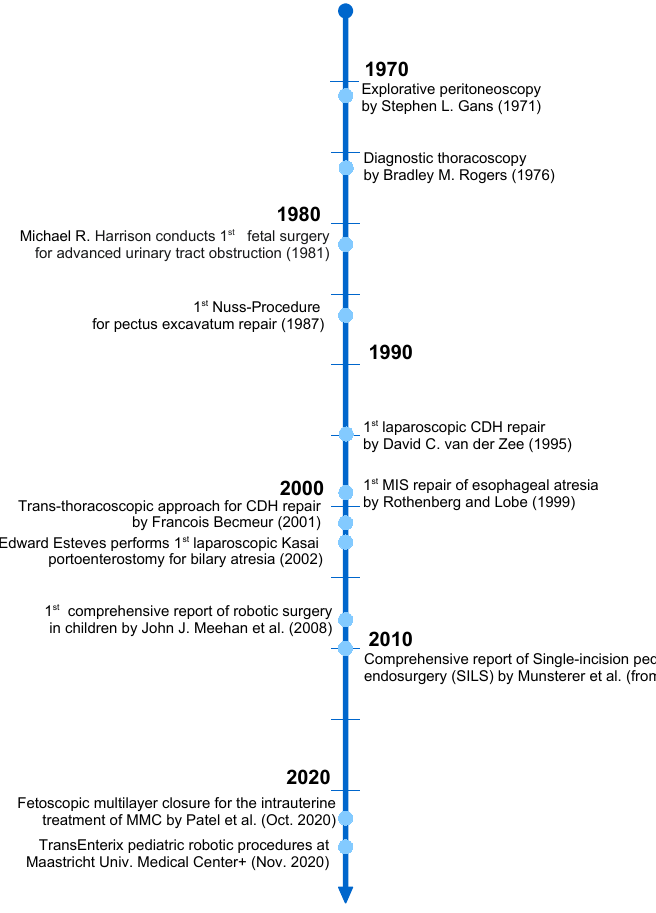
Figure 1. Timeline of the milestones of minimally invasive